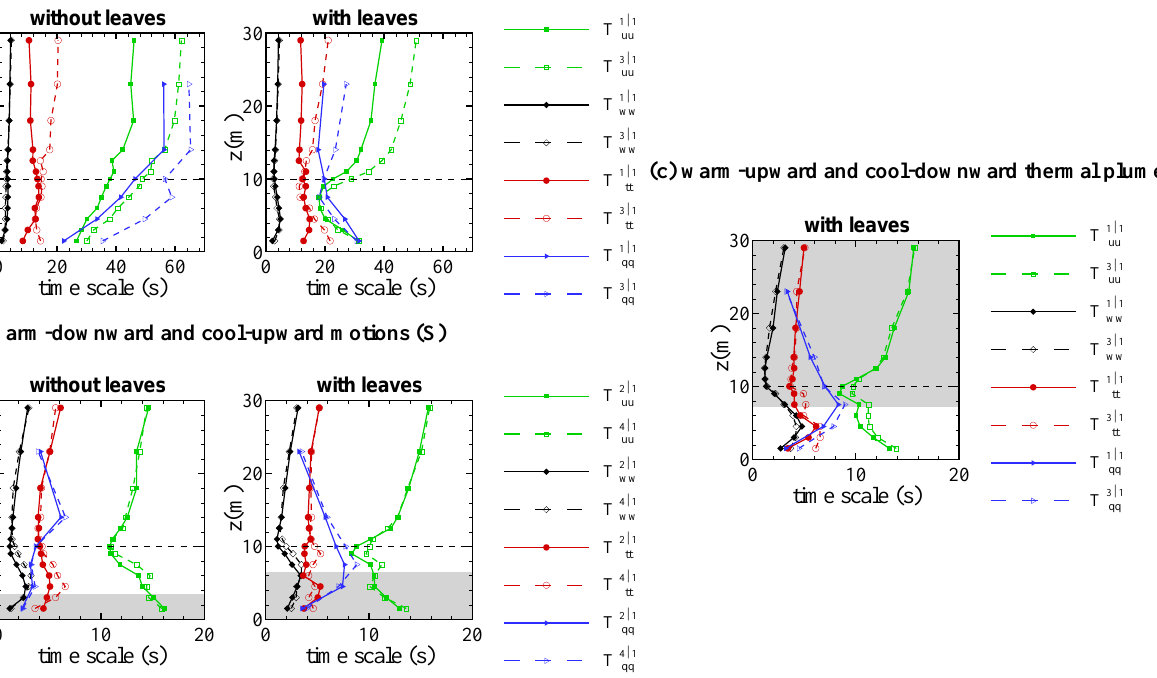
Fig. 9. Temporal scales of u , w , t and q associated with (a) warm upward and cool downward plumes in FrC regime, (b) warm downward and cool upward motions in S regime and (c) warm upward and cool downward plumes in S regime, for both seasonal periods. Note that the temporal scales correspond to (a) T 1 the canopy top and the grey background regions where the motions of interest are not